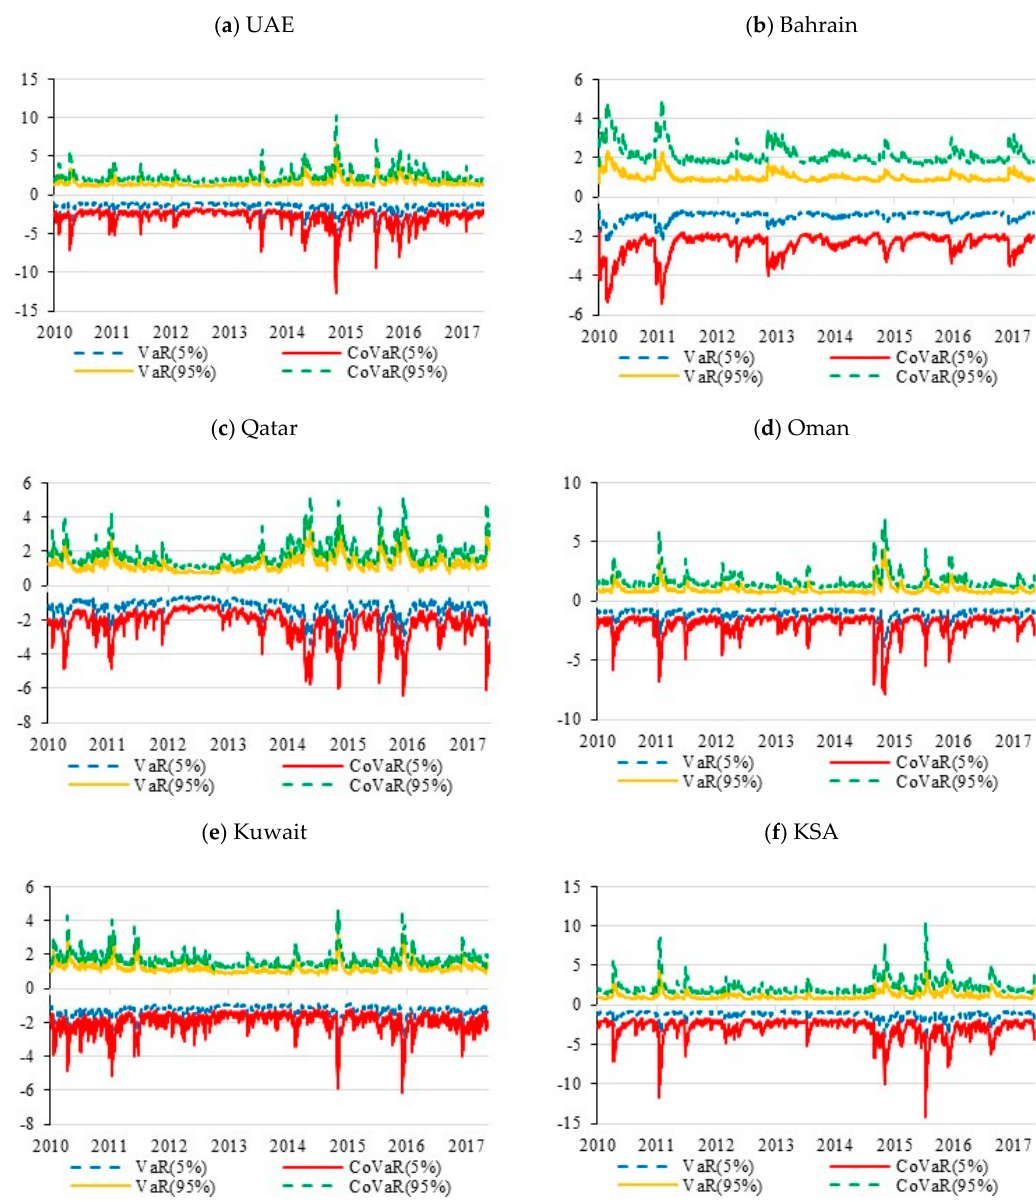
Figure 2. Downside and upside price spillovers from S&P 500 banking sector to the GCC banking sector markets: ( a ) UAE; ( b ) Bahrain; ( c ) Qatar; ( d ) Oman; ( e ) Kuwait; ( f )